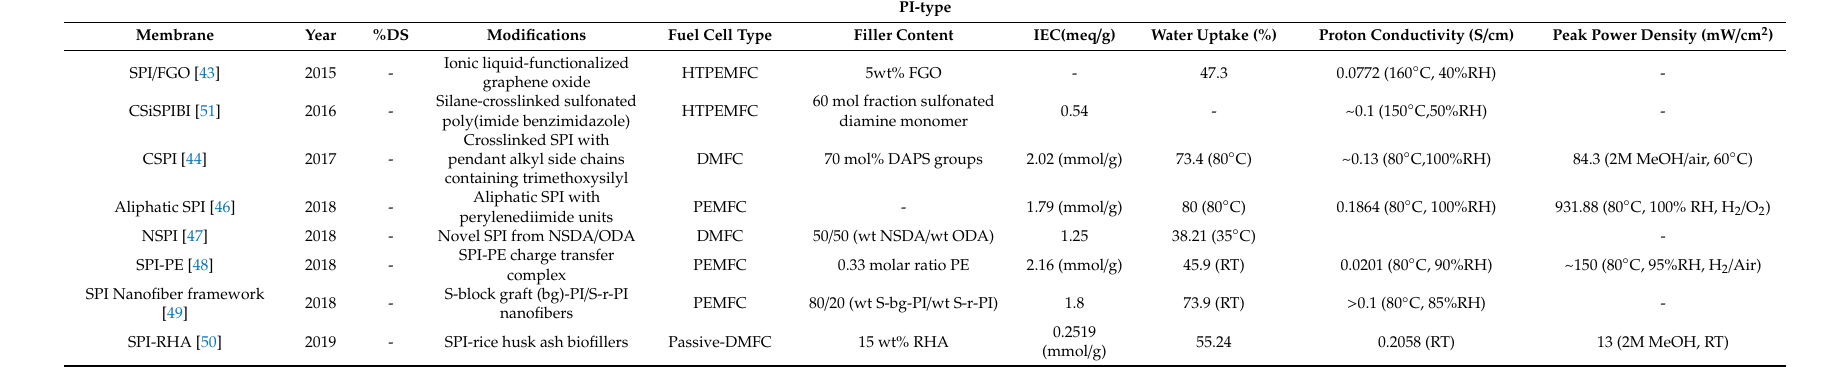
Table 4. Water uptake and electrochemical properties ofpolyimide(PI)-type